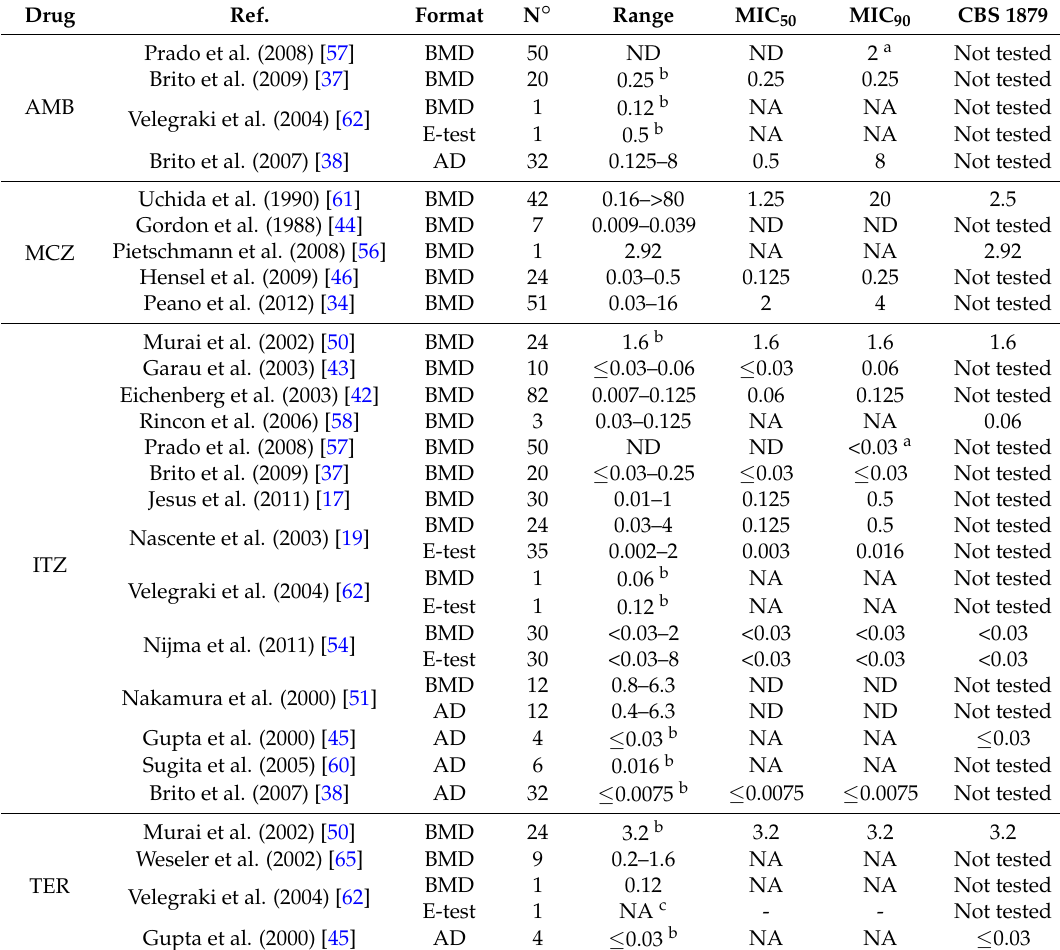
Table 2. Some minimum inhibitory concentrations (MICs, µ g/mL) of different antifungal agents against isolates of M. pachydermatis reported in the